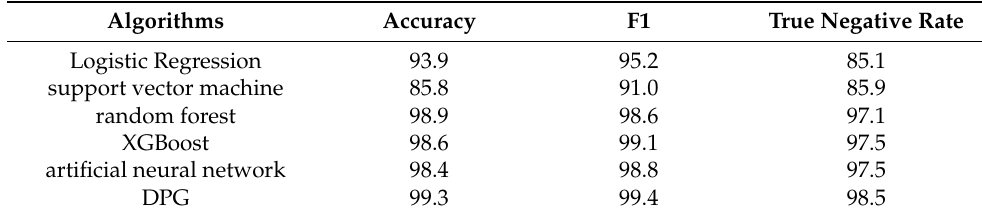
Table 3. Comparison of prediction results of different machine learning methods on IEEE 30 bus system.